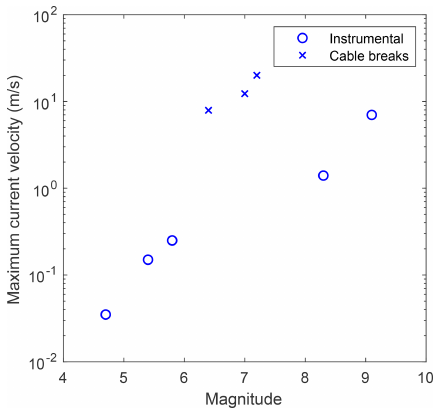
Figure 9. Maximum measured current velocity as a function of earthquake magnitude for the cases discussed in